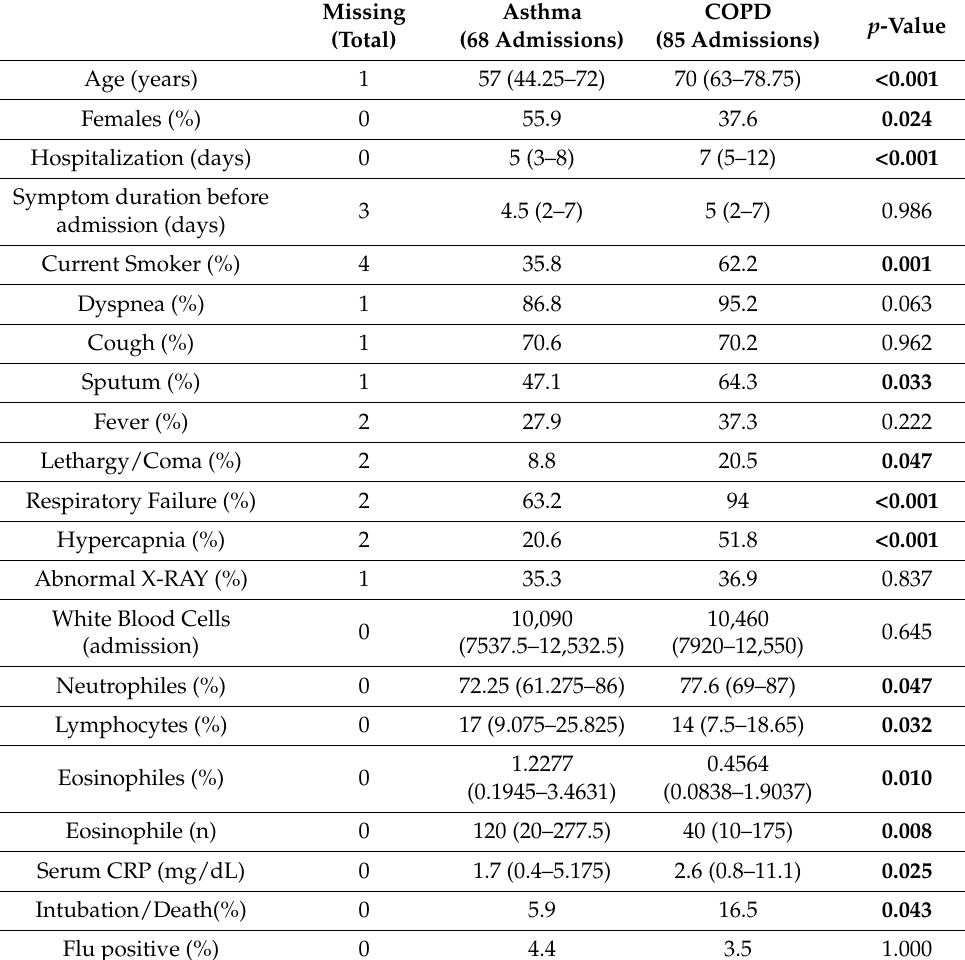
Table 1. Characteristics of asthma and COPD hospital admissions ( n =